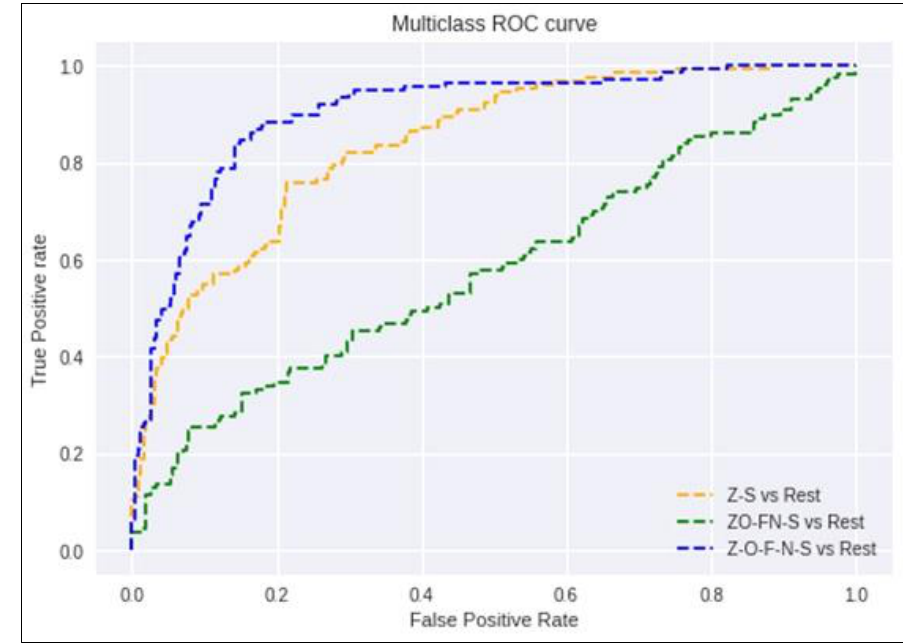
Figure 4. Multi-class ROC curve of the proposed